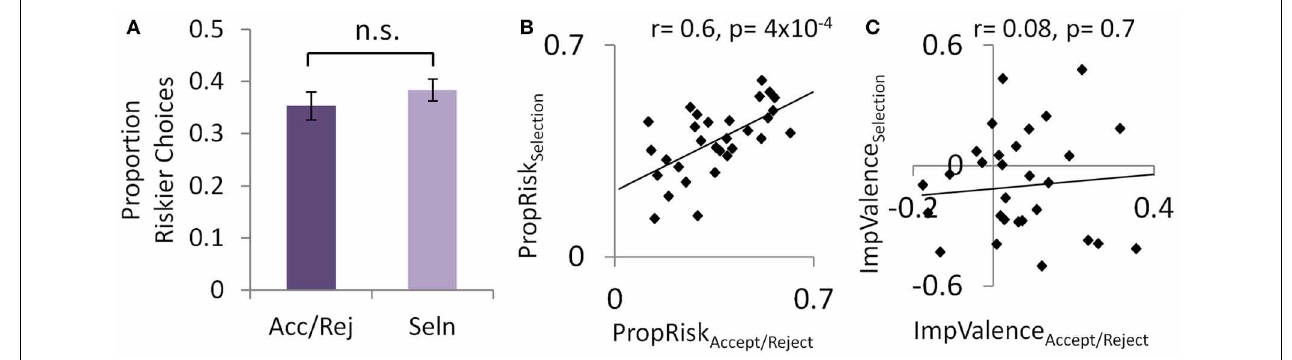
FIGURE 2 | Experiment 1: consistent base-level of risk-taking within individuals. (A) Across subjects risk-taking was consistent between the accept/reject task and selection tasks, despite reversing the direction of the